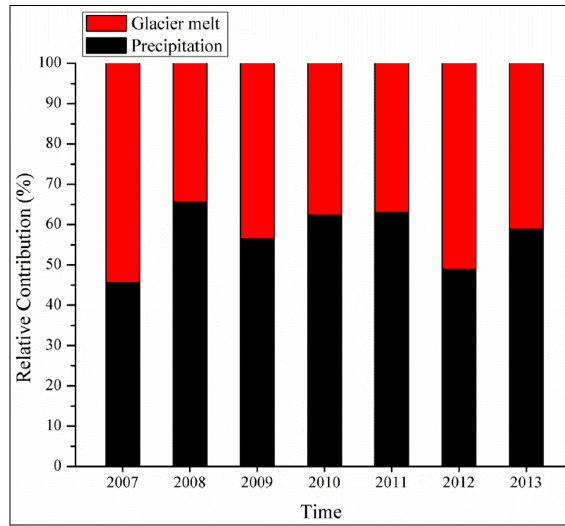
Figure 7. The relative contribution of precipitation and glacier melt to the Nam Co Lake.